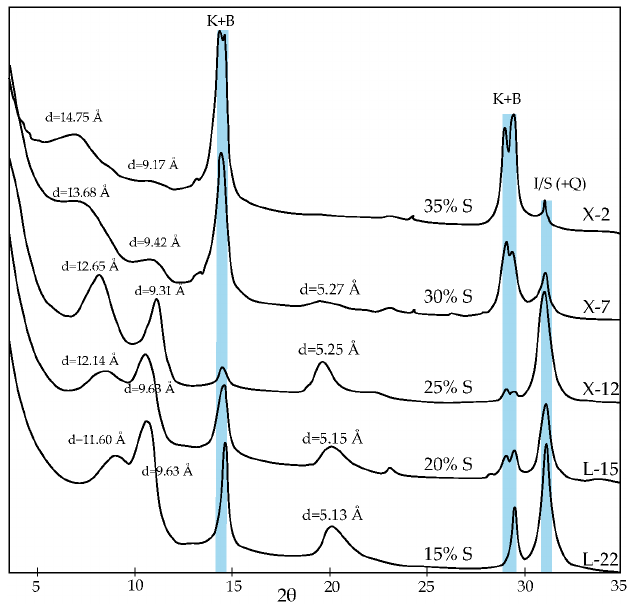
Figure 7. XRD patterns for EG-solvation slides with S (%) = 15, 20, 25, 30, 35, respectively. Blue bars indicate the synthetic peaks at 7, 3.5 and 3.3 Å. Abbreviations are the same as Figure 3.